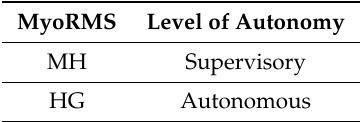
Table 4. Rules for MyoRMS and Level of